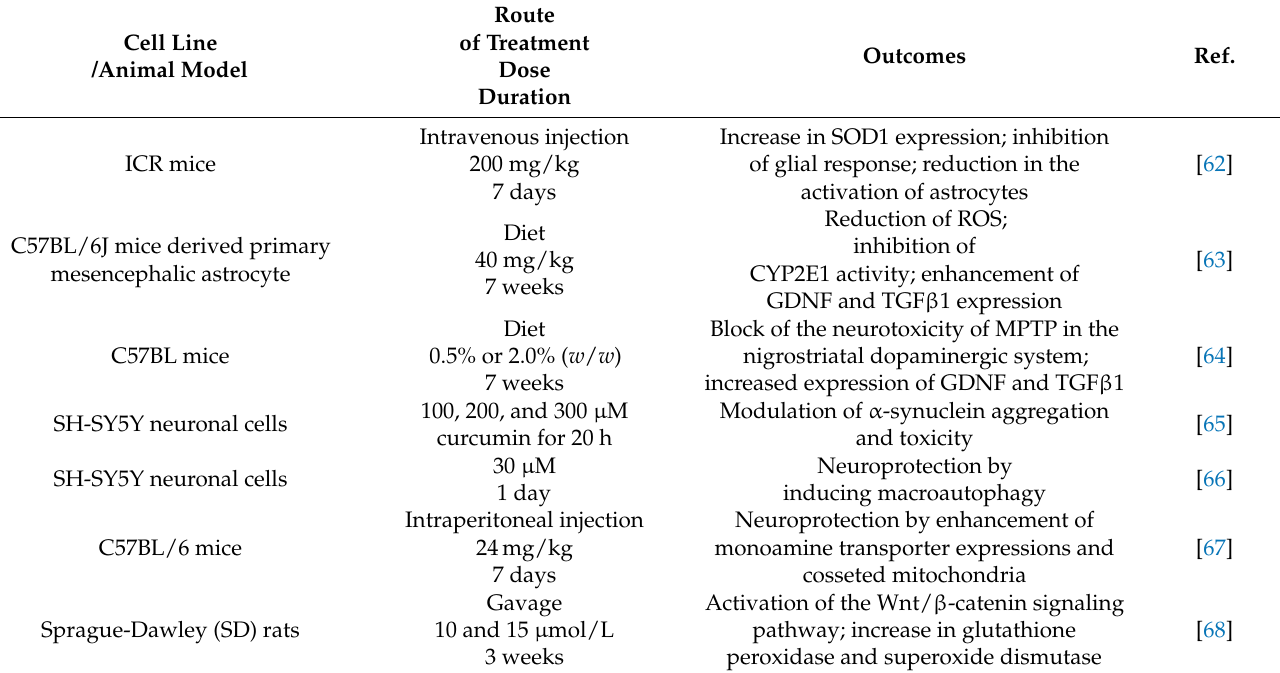
Table 1. In vitro and in vivo studies of curcumin on Parkinson’s